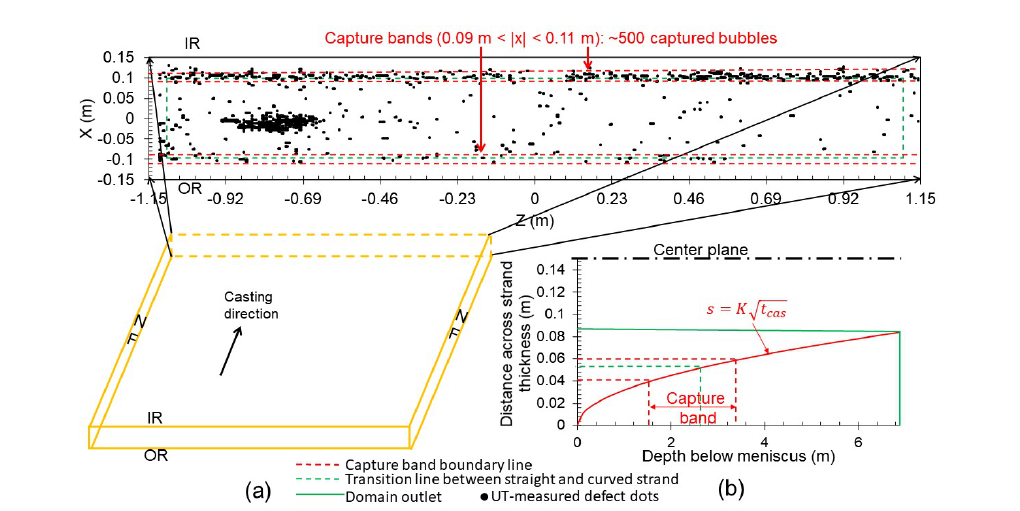
Figure 15. UT measurements: ( a ) Schematic showing slab and particle capture locations; ( b ) capture band location on the shell thickness profile.